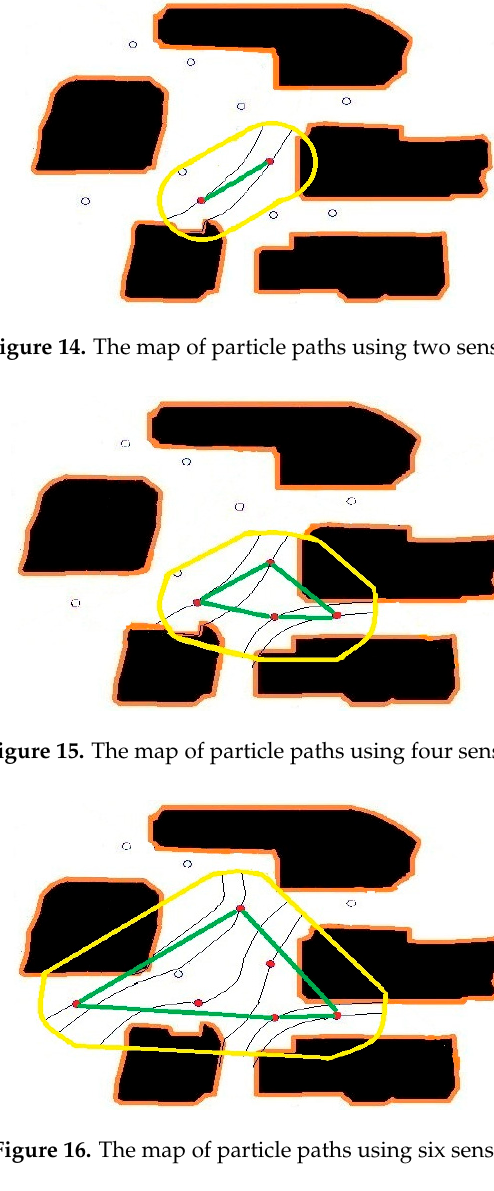
detection algorithm. Sensors 2016 , 16 , 1034